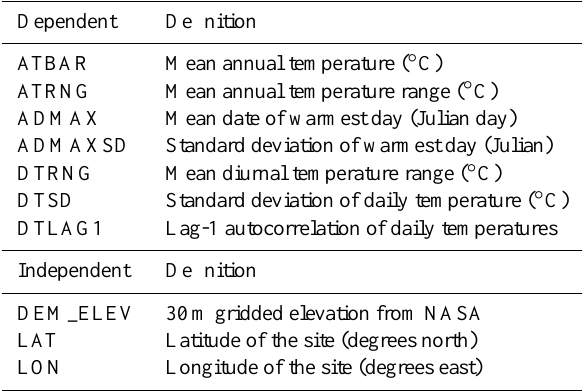
Comparison of TRMM(V7) with observed mean annual rainfall at Network A sites. Figure 5 y = 1.0219x